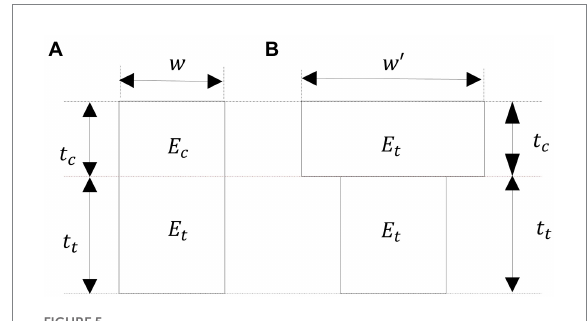
FIGURE 5 Conversion of the equivalent